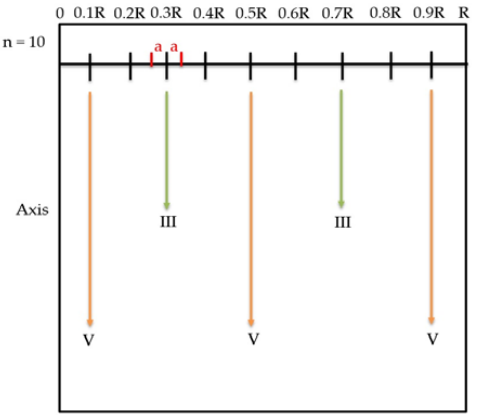
Figure 3. Schematic reactor diagram for the approximate approach.